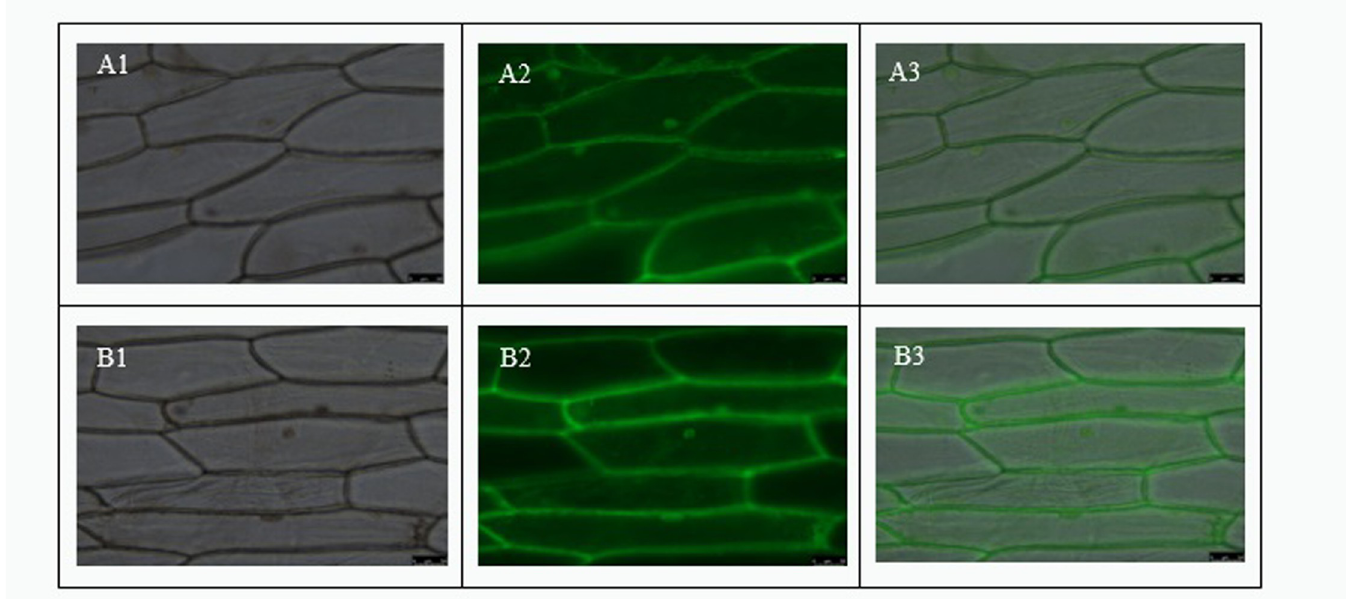
Fig 11. Observation of subcellular localization. Note: A1, A2, A3: Protein expression results of non-transformed cells under bright field, green fluorescence, and superimposed conditions; B1, B2, B3: Expression results of RcHA 4 protein under bright field, green fluorescence, and superimposed conditions.